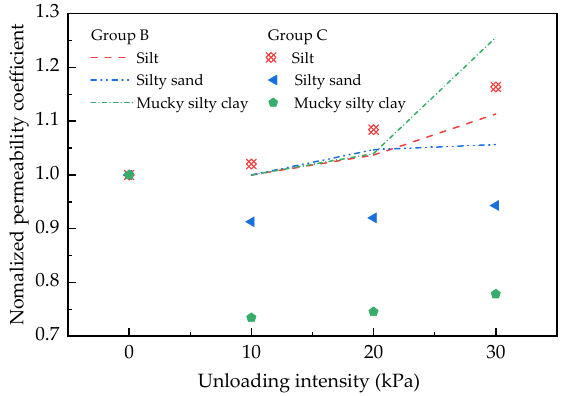
Figure 11. Normalized permeability coefficient-unloading intensity relationship of three soils in dif- under different stress ferent stress paths.